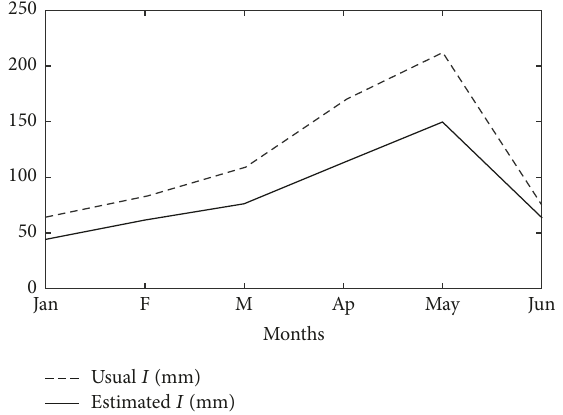
Figure 4: Usual and estimated irrigation water.